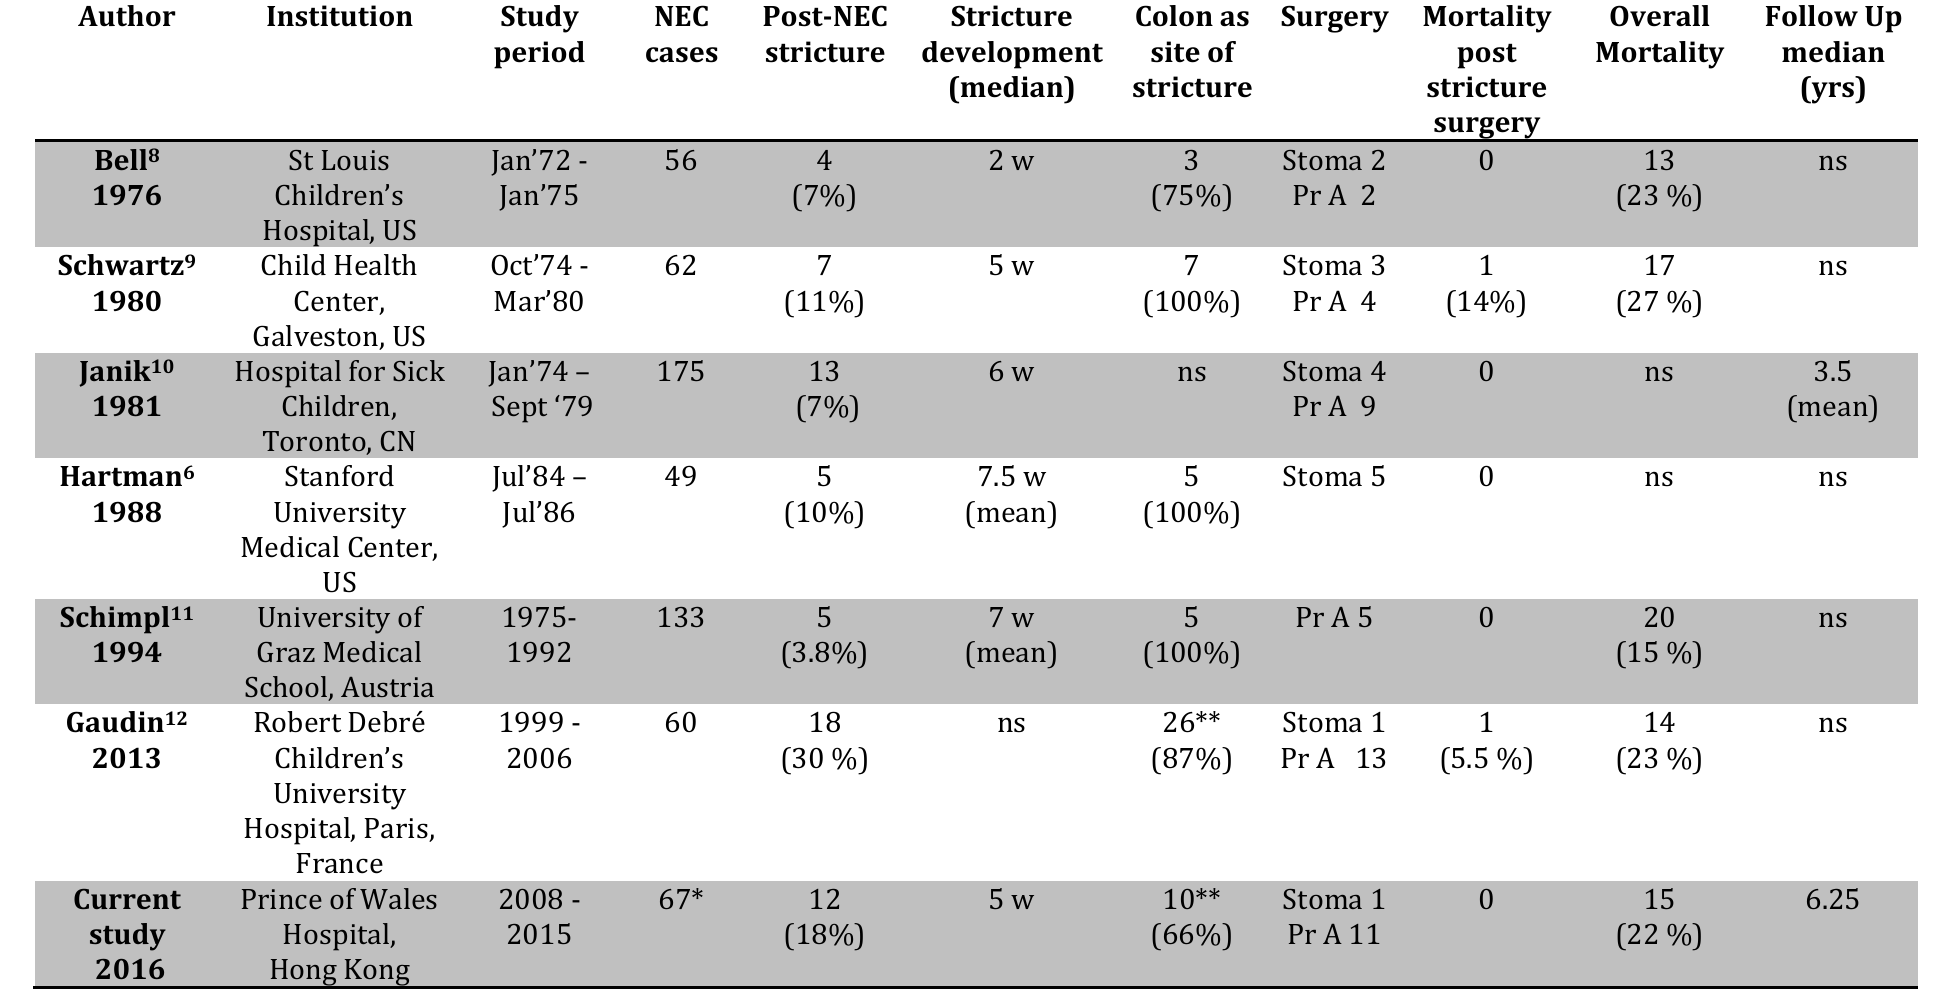
Table 1: Frequency and outcome of post-NEC strictures at different